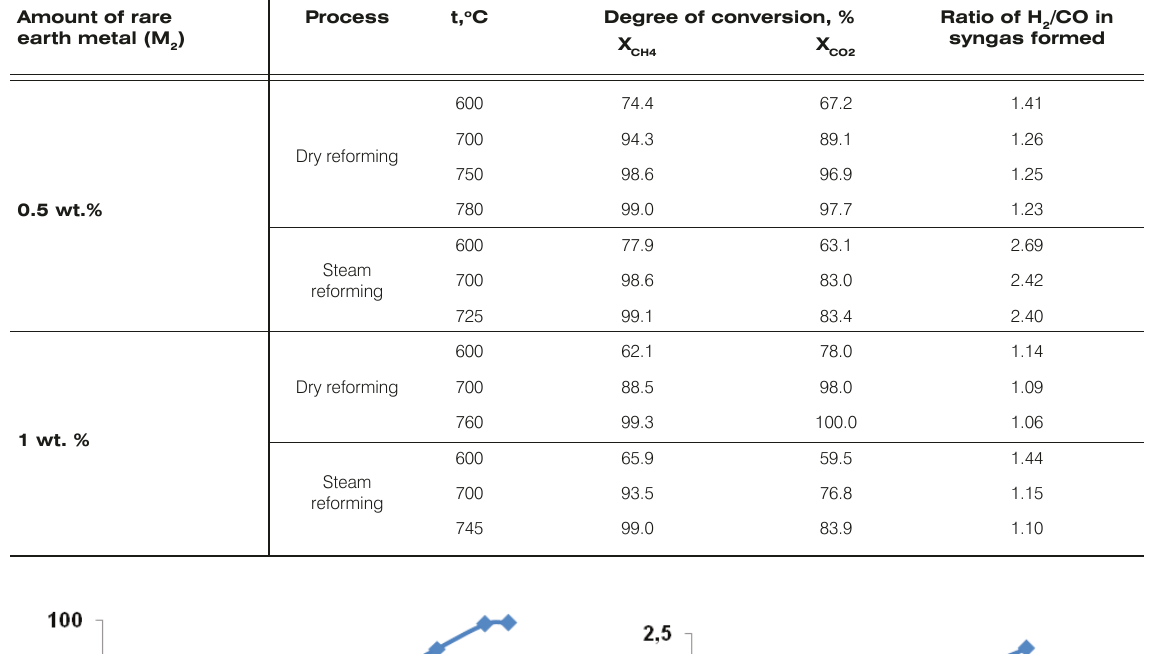
Table 1. Comparative characteristics of the Co-M Amount of rare earth metal (M